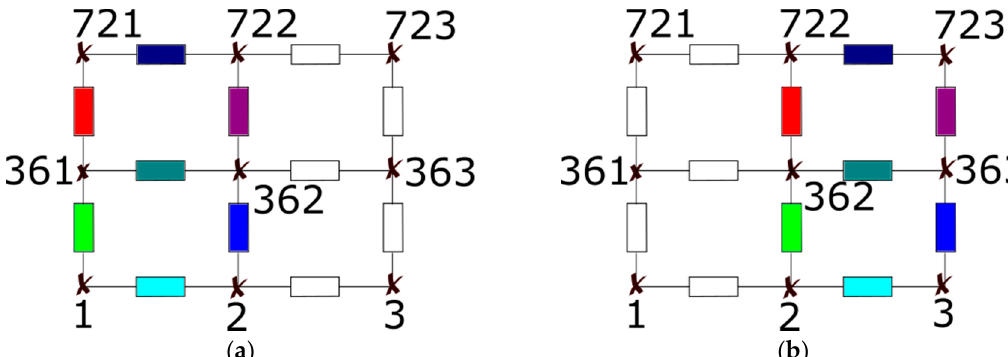
Figure 11. Demonstration on the motion simulation process through reluctance manipulation. Each color represents a certain reluctance value and is added just for illustration: ( a ) initial position of the nodes and their connected reluctances; ( b ) the new reluctance distribution after one step rotor movement.